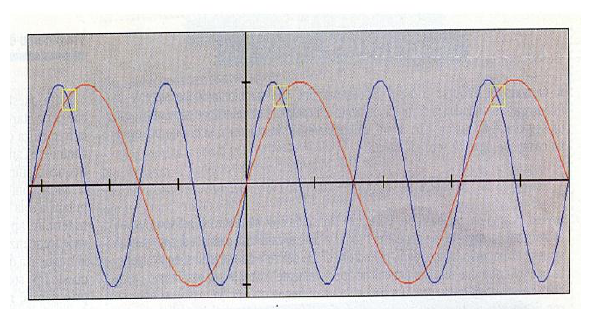
Figure 6. Image aliasing